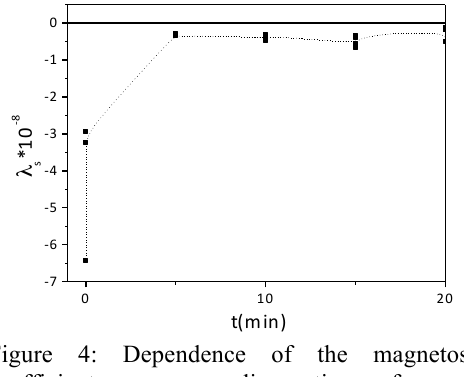
Figure 4: Dependence of the magnetostriction coefficient on annealing time for